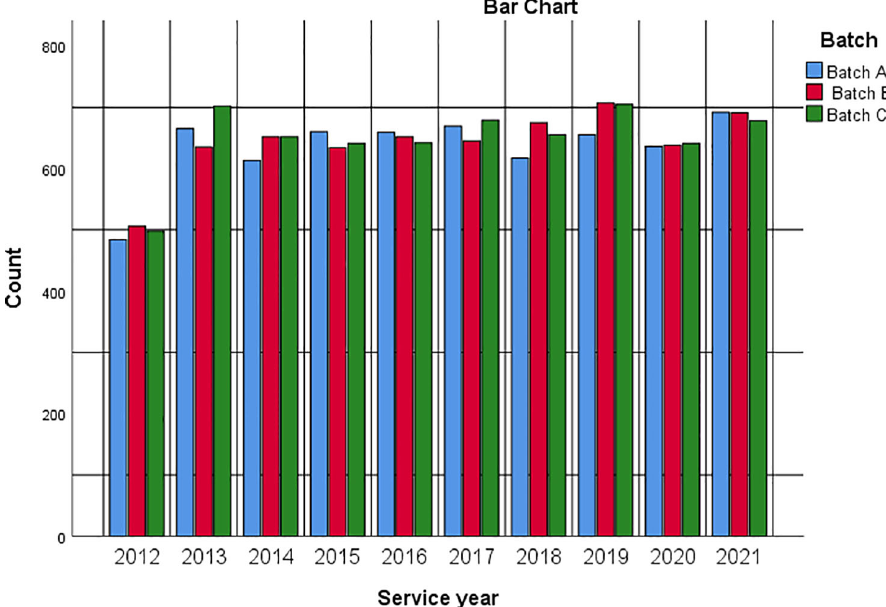
Figure 2. Bar chart showing respondents ’ service year based on service